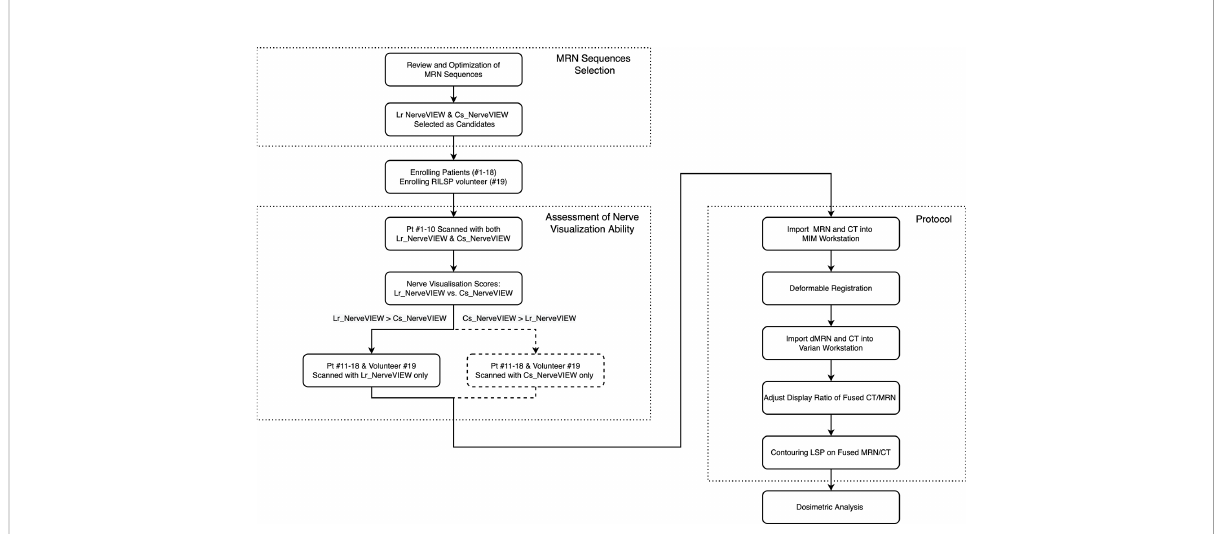
FIGURE 1 Study design fl owchart. The fl owchart boxes represented by dashed lines refer to the case when cs_NerveVIEW performed better than Lr_NerveVIEW in the assessment of nerve visualization ability, which did not occur in this study. Pt #., patient number; dMR, deformed